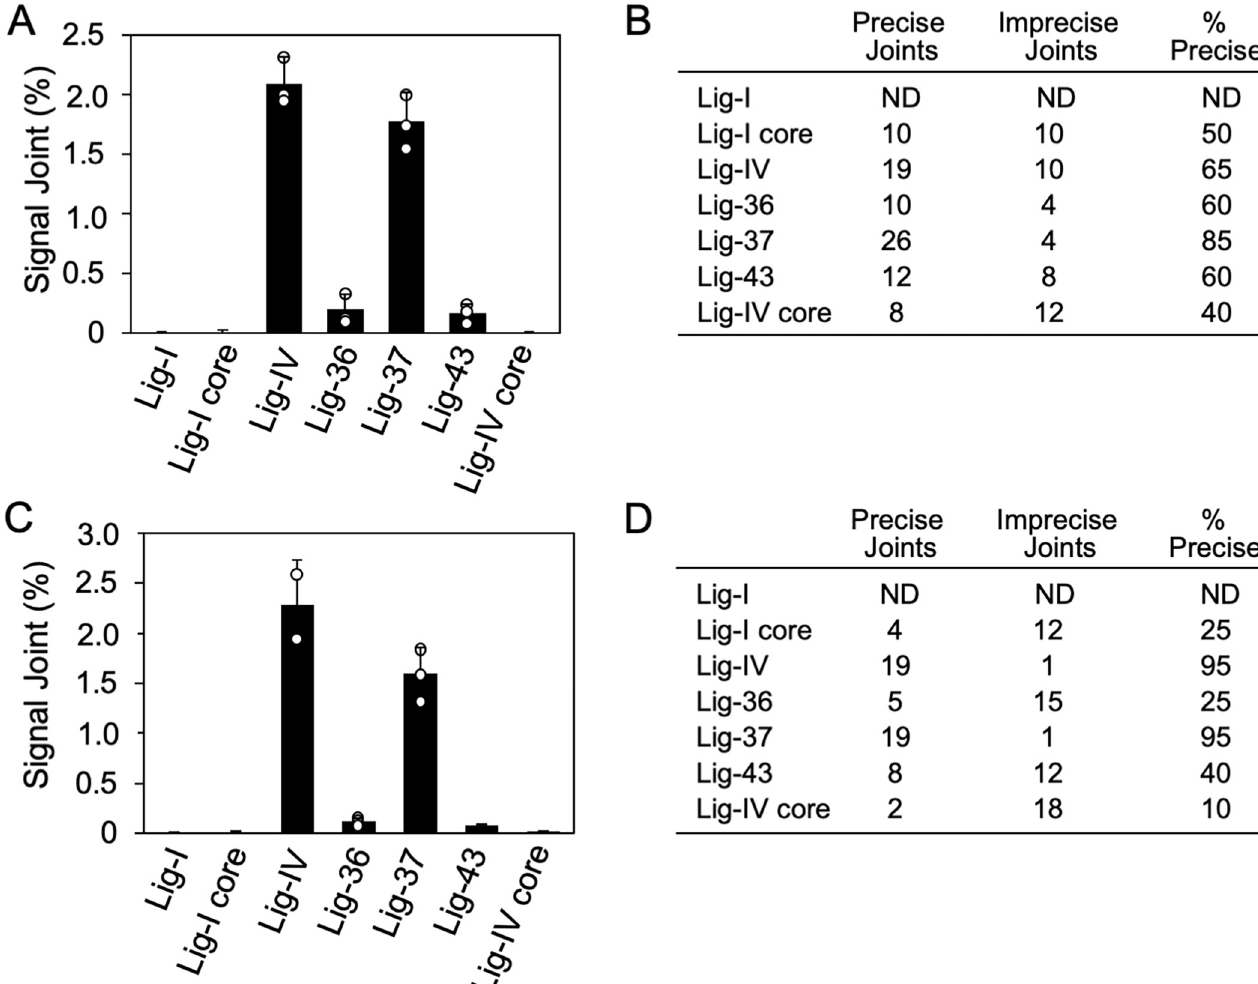
Fig 4. Lig-37 supports signal joint formation. A. Lig-37 supports signal joint formation in Lig-IV-deficient human pre-B cells. Lig-IV-deficient N114P2 human pre-B cells were transiently transfected with Flag-tagged chimeric ligase expression vectors or controls, along with the signal joint (SJ) substrate, pGG49. Two days post transfection, plasmid DNA was extracted from the cells and digested with DpnI, followed by transformation. SJ formation was determined by a colony formation assay as described [32]. Percent of SJ formation is shown in the y-axis. Error bars are from the evaluation of three biological replicates. The individual data points from the biological replicates are depicted within the graph. B. and D. Percent of precise signal joints generated by the chimeric ligases. For the SJ analysis performed in B and D, two independent experiments were done. The results from both experiments were combined and are presented in the tables. C. Evaluation of SJ formation in Lig-IV MEFs. Similar to the experiment presented in A, however, Lig-IV deficient MEFs were transfected with the murine SJ recombination substrate pJH200 [34]. Error bars are from the evaluation of triplicates performed in this experiment, except for the Lig-IV data point that shows the average of two biological replicates. Data presented in A and C is representative of two independent